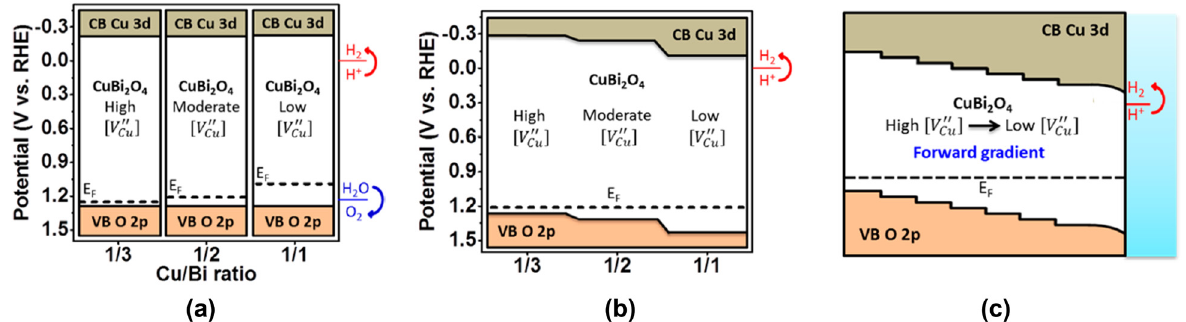
Figure 11: ( a ) Band positions of nonstoichiometric CuBi 2 O 4 fi lms before contact. ( b ) Equilibration of Fermi levels and corresponding band bending at the interfaces upon contact. ( c ) Formation of CuBi 2 O 4 with forward gradient. ( Reprinted with permission from ref. [ 164 ] . Copyright © 2017, American Chemical Society ) .